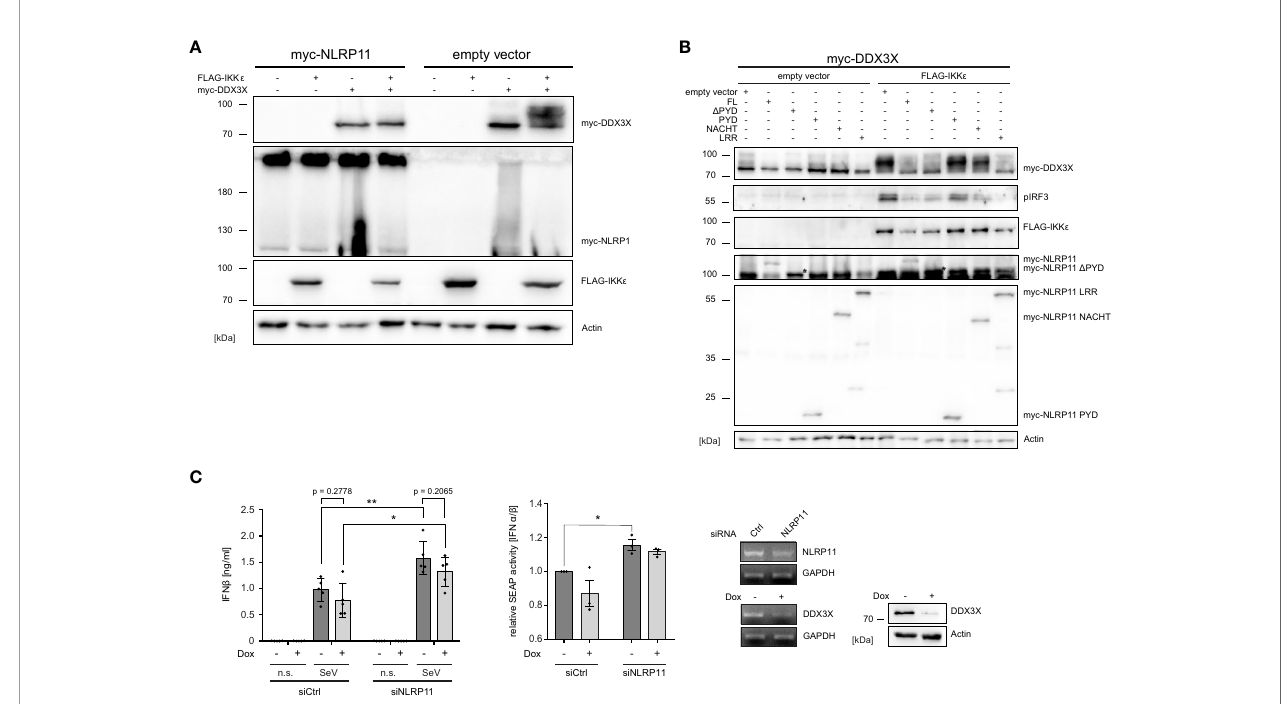
FIGURE 3 | NLRP11 inhibits the phosphorylation of DDX3X by IKK ϵ . (A, B) Immunoblot of whole cell lysates from HEK293T cells expressing FLAG-IKK ϵ , myc- DDX3X and either myc-NLRP11 (A) , or myc-NLRP11 deletion constructs (B) as indicated. Blots were probed for myc, FLAG, pIRF3 and actin as loading control. Representative blots of at least two independent experiments are shown. *, myc-NLRP11 D PYD (C) IFN b release from macrophage-like differentiated shDDX3 THP1 cells. DDX3X targeting shRNA was expressed by induction with doxycycline (Dox) for 48 h and NLRP11 was targeted by siRNA transfection for 72 h, as indicated. Cells were infected with SeV for 16 h. IFN b quanti fi cation by ELISA (left graph) and bioassay (right graph) are shown as means ± SEM (IFN b : n = 5, SEAP: n = 3, ± SEM). *p < 0.05; **p < 0.01 Welch ’ s, two-sided t-test. Knock-down ef fi ciency of NLRP11 and DDX3X was validated by endpoint PCR, and protein levels of DDX3X by immunoblot (upper panels). Immunoblots were probed for DDX3X and actin as loading control. n.s., not